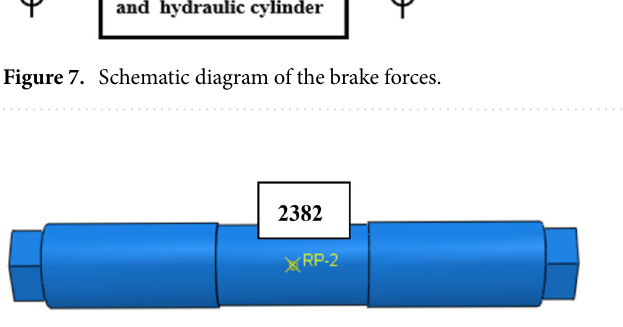
Figure 8. Location of central axis selection points and unit numbering (Abaqus